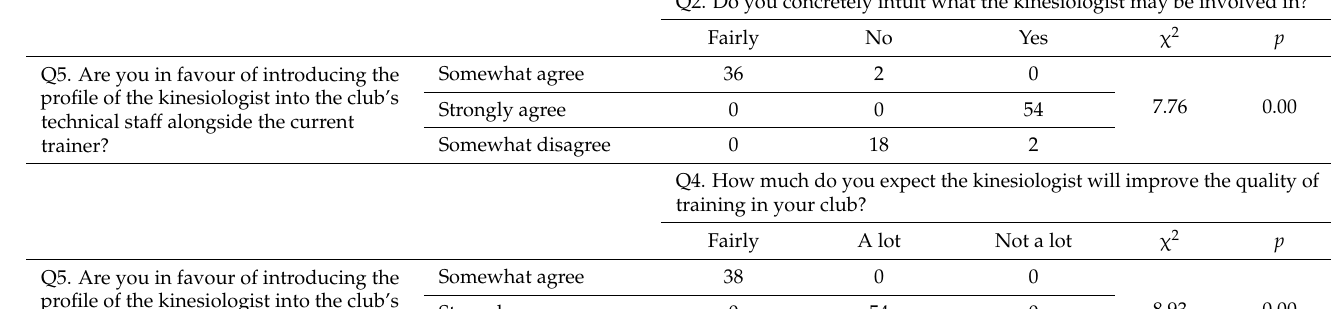
Table 5. Differences in perception found among presidents.